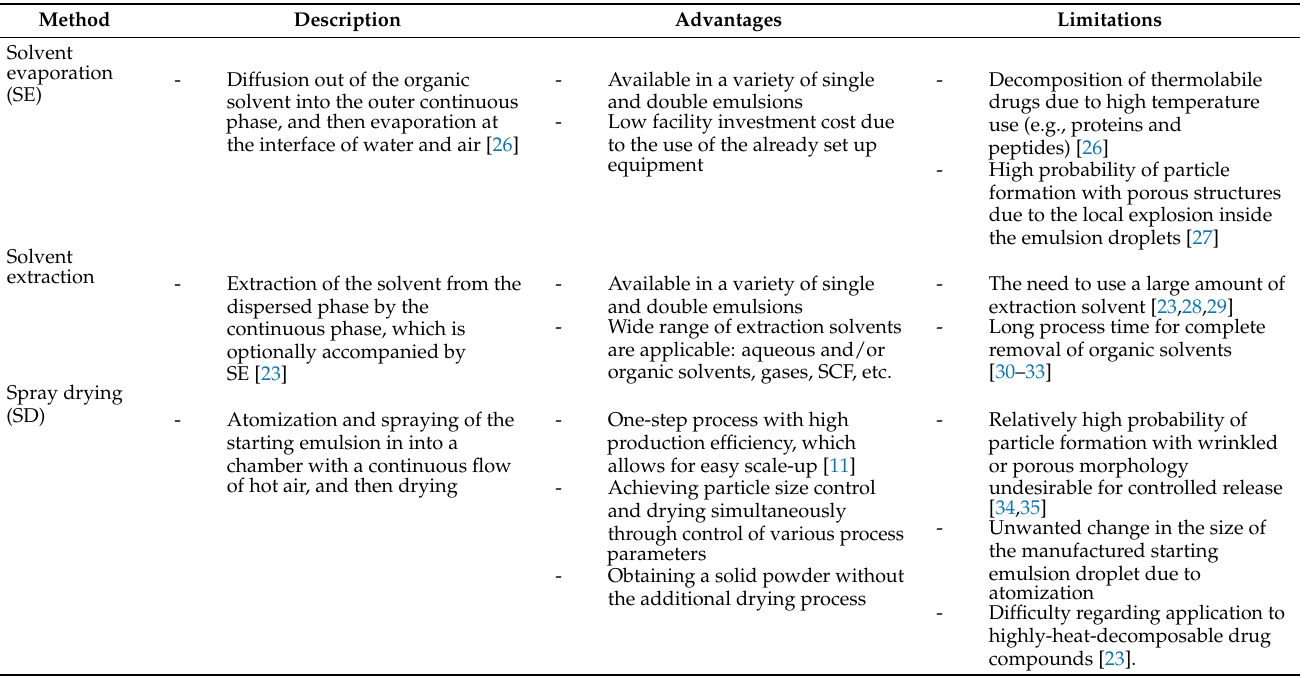
Table 1. Solvent removal methods for micro-/nanoparticle formation.